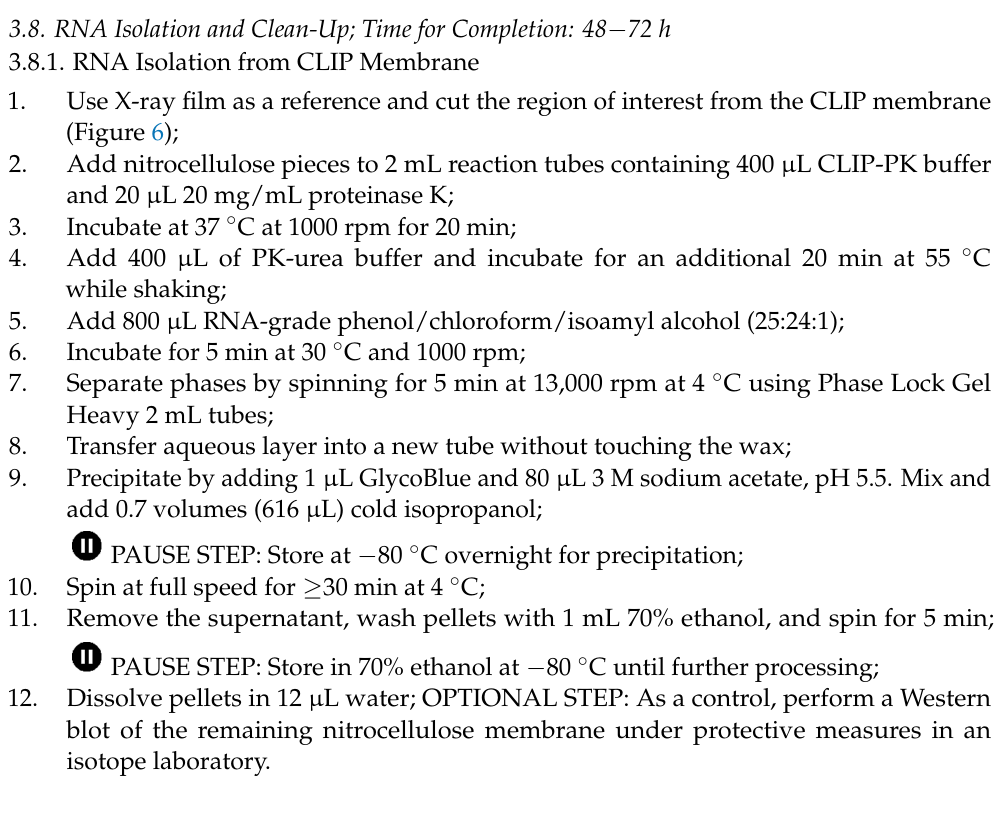
Table 10. PCR Mix for cDNA Preamplification.